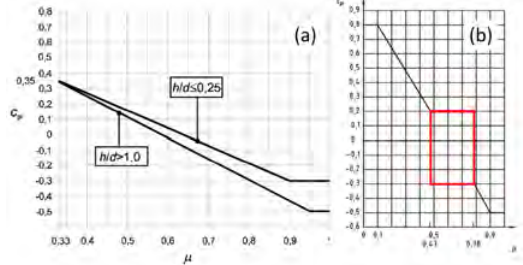
Figure 15. Diagram for the c pi values: (a) Eurocode [1] and (b) the previous code DIN 1055